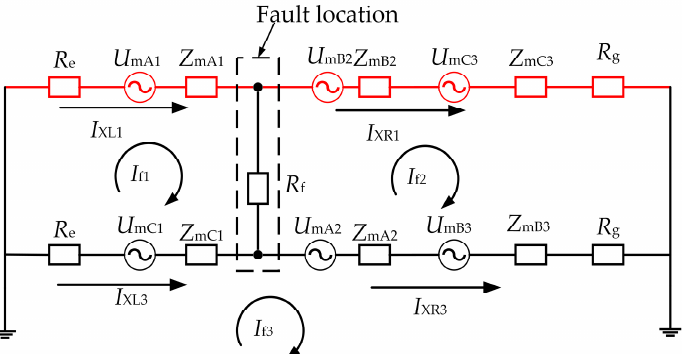
Figure 6. Equivalent circuit diagram of breakdown fault of cable joint JA1.